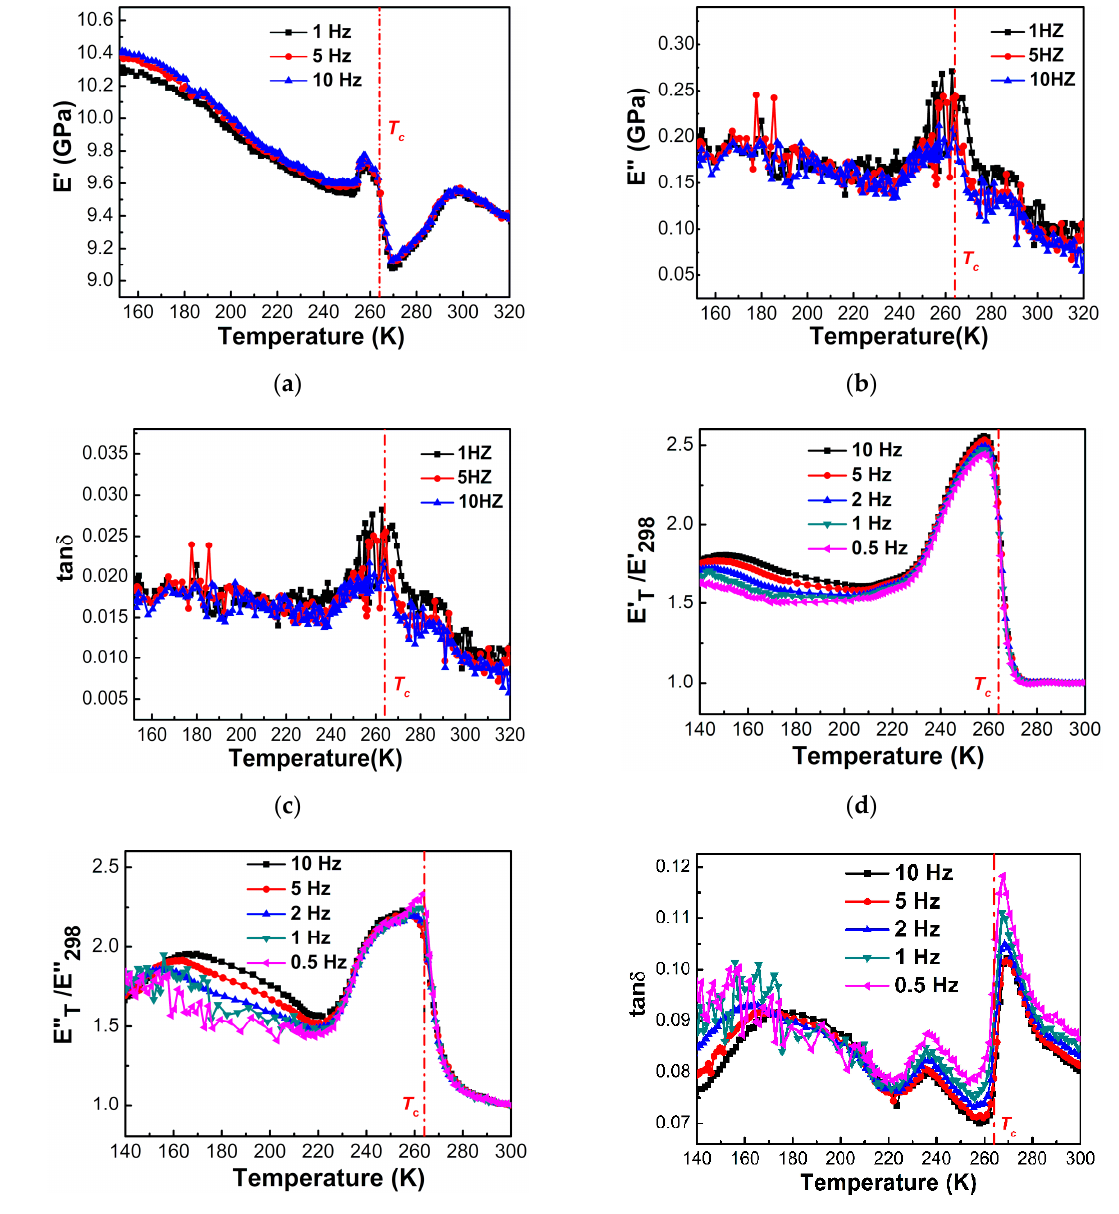
Figure 7. Temperature dependences of ( a ) storage modulus E’, ( b ) loss modulus E’’, ( c ) loss factor tan δ of [(CH 3 ) 2 NH 2 ][Mg(HCOO) 3 ] single crystals, ( d ) normalized storage modulus E’ T /E’ 298 , ( e ) normalized loss modulus E’’ T /E’’ 298 and ( f ) loss factor tan δ of [(CH 3 ) 2 NH 2 ][Mg(HCOO) 3 ] pellet determined by DMA during heating at the rate of 2 K/min. The vertical dash-dotted line indicates the ferroelectric transition temperature of 264 K.